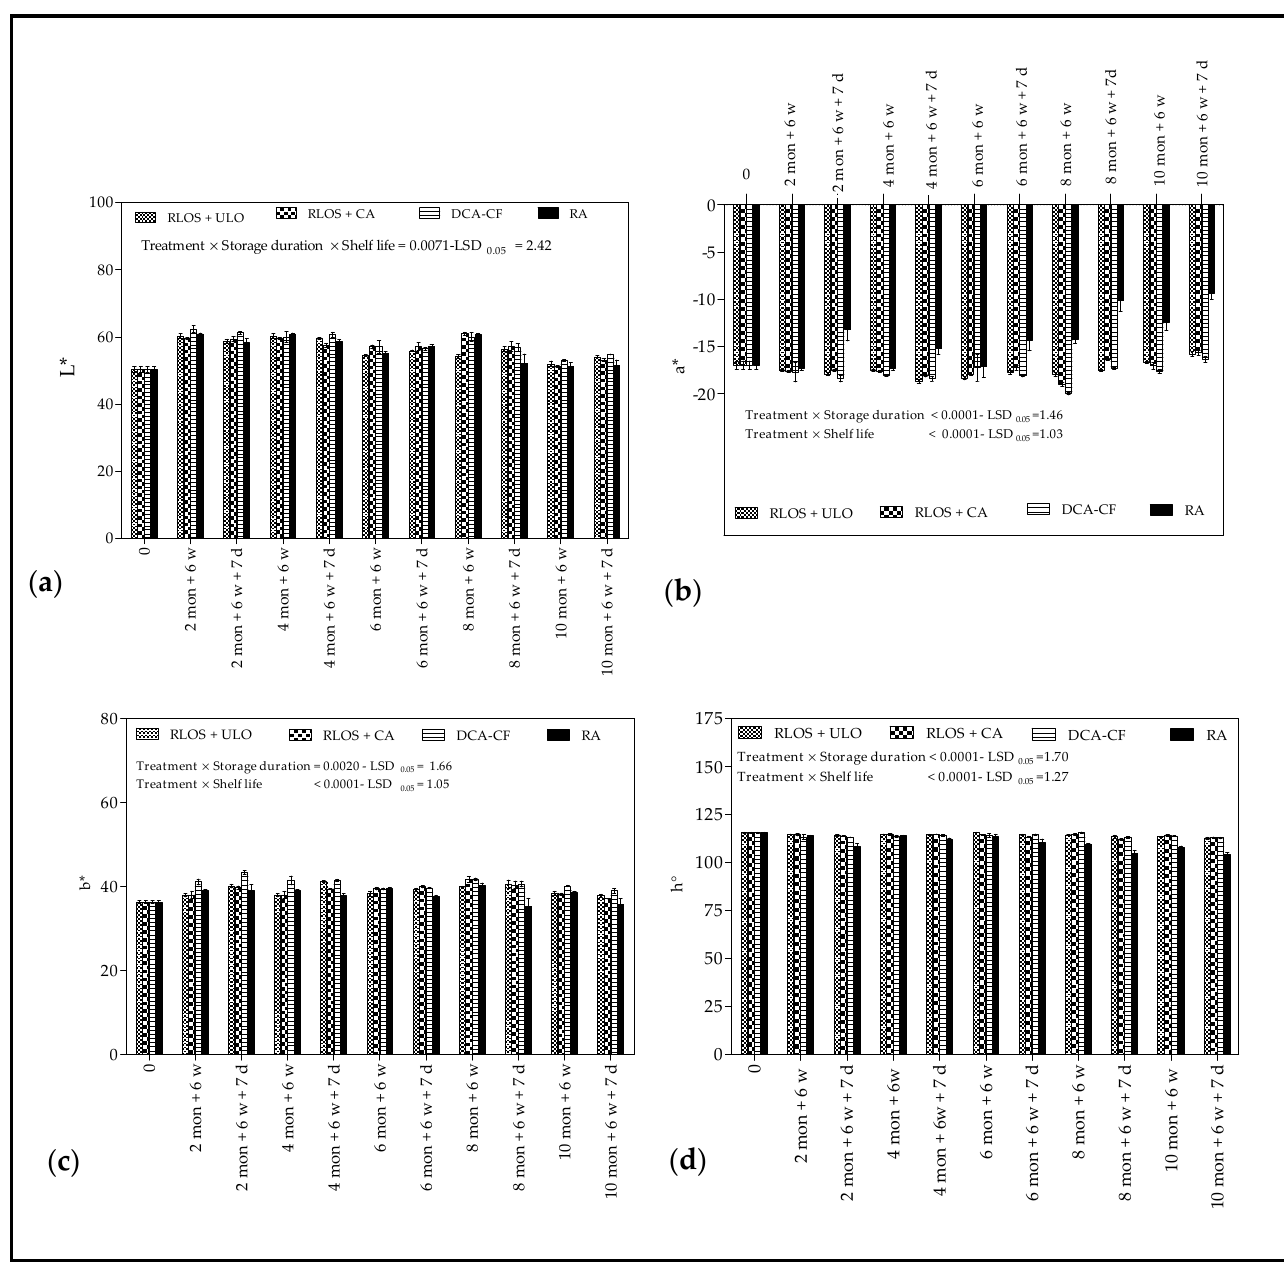
Figure 2. Background color ( a ) lightness (L*), ( b ) redness/greenness (a*), ( c ) yellowness/blueness (b*) and ( d ) hue angle (h°) of ‘Granny Smith’ apples harvested in the 2015 season at commercial maturity and stored for up to 10 months at 0 °C in various storage conditions, evaluated every two months followed by a 6 week simulated shipment and handling period, and at 7 days on the shelf (20 °C and 65% RH). Vertical bars represent the standard error (SE) of mean values of 3 replicates (1 replicate = 10 fruit). LSD 0.05 represents least significant difference ( p < 0.05). For storage duration, mon—months; w—weeks; and d—days. RLOS—repeated low oxygen stress; ULO—ultra-low oxygen; CA—controlled atmosphere; DCA-CF—dynamic controlled atmosphere-chlorophyll fluorescence; RA—regular atmosphere.